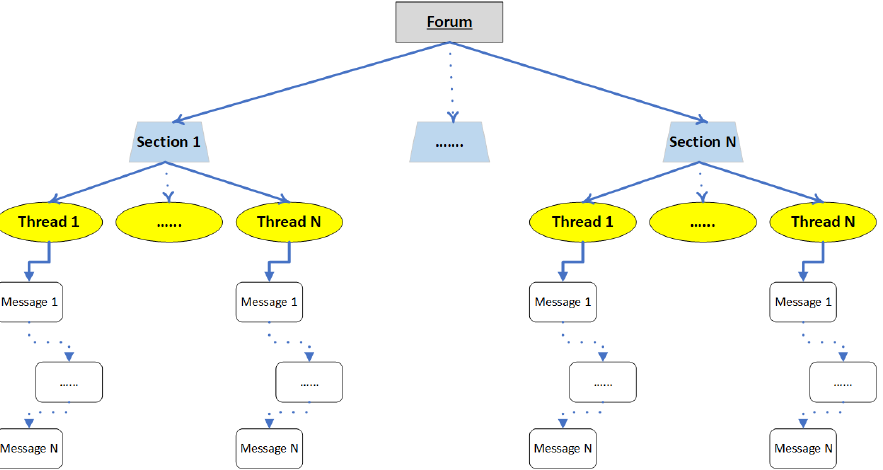
Figure 2. Common Discussion Forum